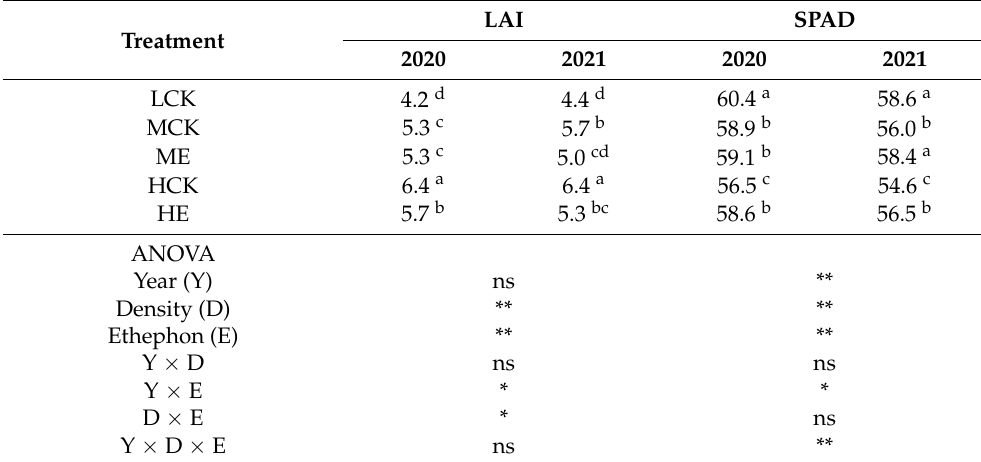
Table 1. Effects of spraying ethephon on LAI and SPAD of summer maize. LAI SPAD Treatment